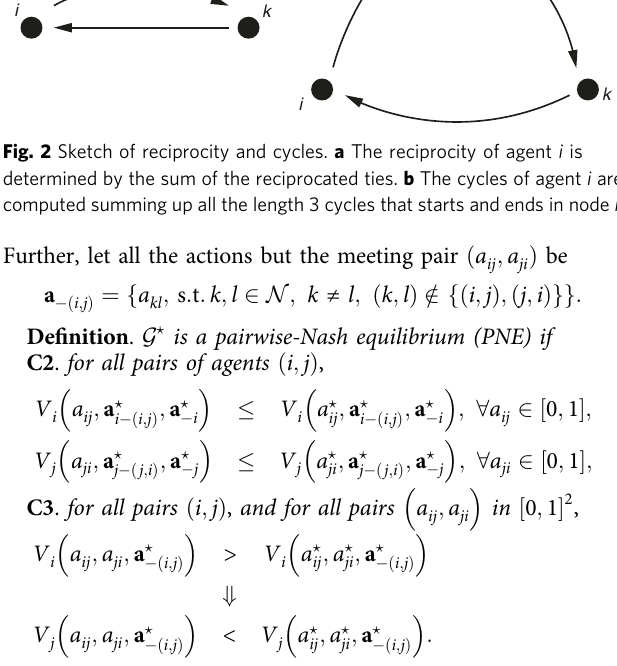
In the above de fi nition, (C2) is the Nash, or sel fi sh, condition which requires that, for every pair ð i ; j Þ of agents, neither i nor j can be sel fi shly better off by changing just her individual outgoing vice versa, due to the different action spaces; see Remark 2 and Supplementary Fig. 1 in Supplementary Note 1. On the other hand, (C3) is the cooperative condition, stating that at equilibrium there is no pair of agents who can both be better off by coordinating their actions. Note that (C3) is a Pareto optimality condition (see the Supplementary Note 1).